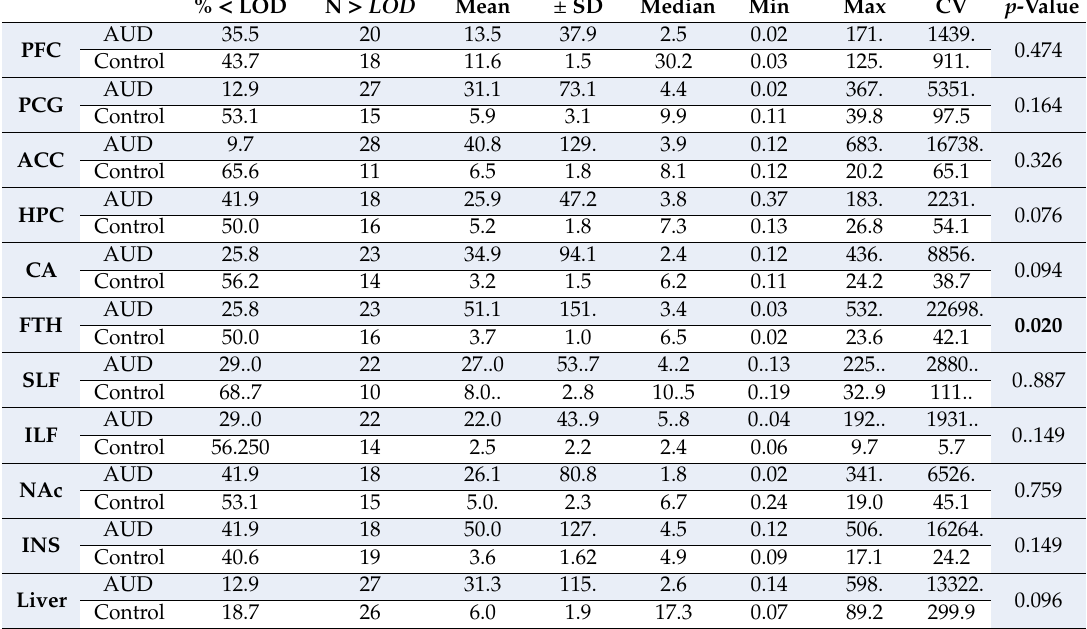
Table 4. Content of Si in AUD ( n = 31) and control ( n = 32) subjects in di ff erent brain structures and in the liver (mg /